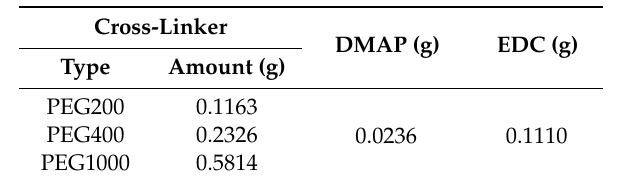
Table 1. Reagent quantities calculated per 0.25 g of poly- γ -glutamic acid ( γ -PGA). Note: DMAP, 4-dimethylaminopyridine; EDC, 1-(3-dimethylaminopropyl)-3-ethylcarbodiimide hydrochloride; PEG, poly(ethylene